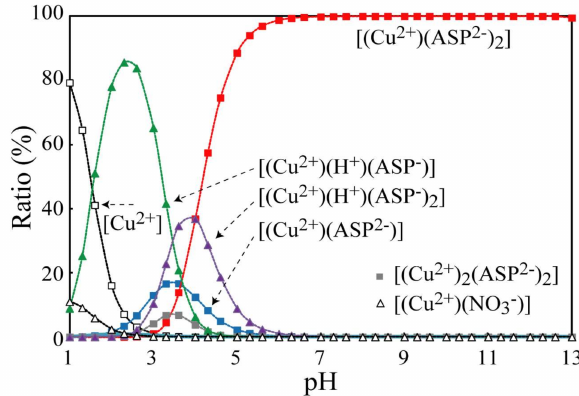
Figure 1. Results of the calculation in the cases of Cu-ASP-OH system as a function of pH, (C Cu = 0.01 mol/L, C NO = 0.02 mol/L, and C ASP = 0.06 3